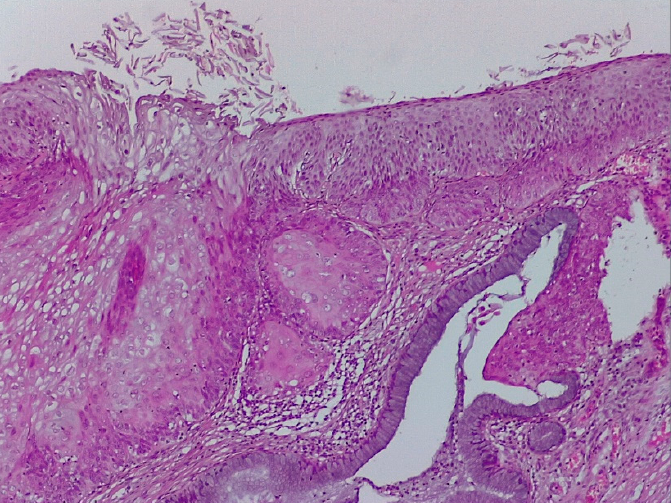
Figure 13. Pathological specimen of the case described in Figure 9: microinvasive carcinoma, superficial ulceration, broken basal membrane, and presence of the keratinization foci in stroma. The columnar epithelium is normal. (Hematoxylin–eosin 10×.)